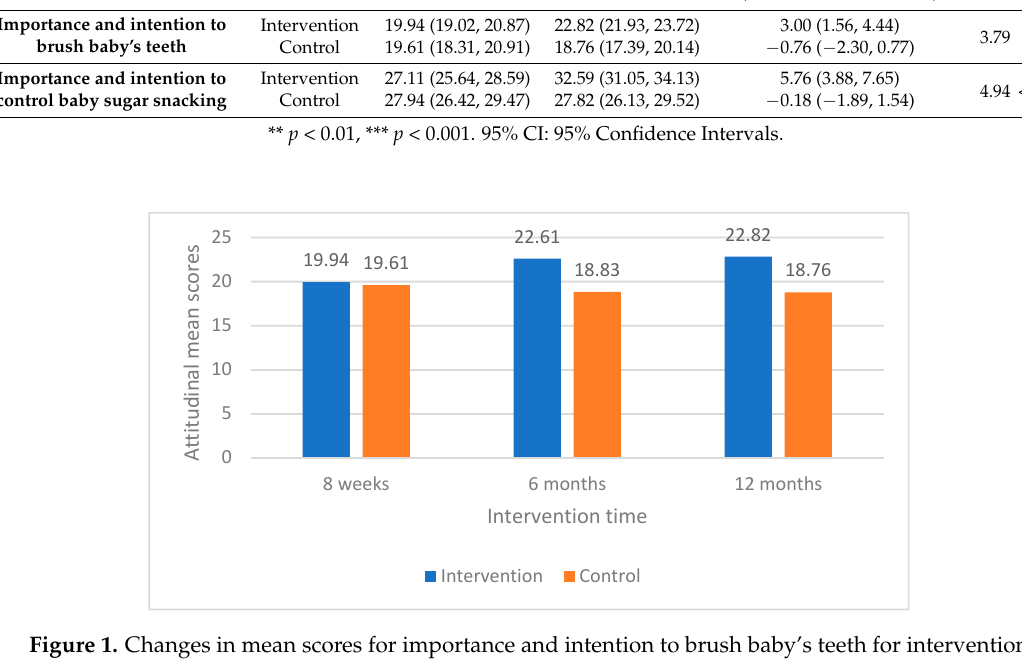
Figure 1. Changes in mean scores for importance and intention to brush baby’s teeth for intervention and control groups.